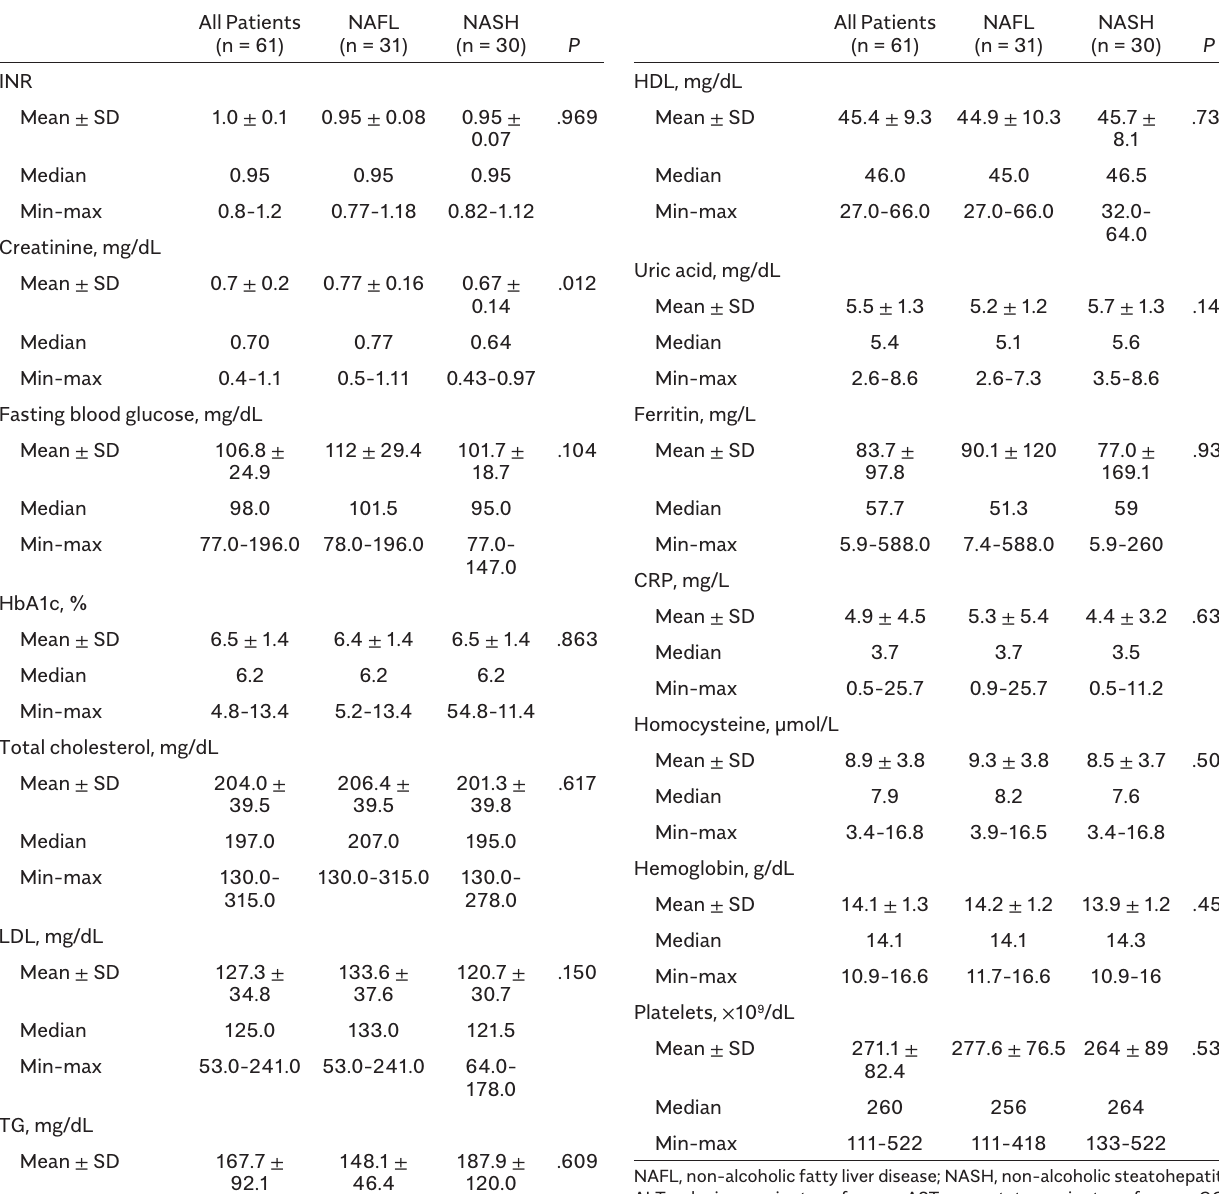
Table 1. Baseline Characteristics of NAFLD Patients who Are Included in the Study ( Continued )